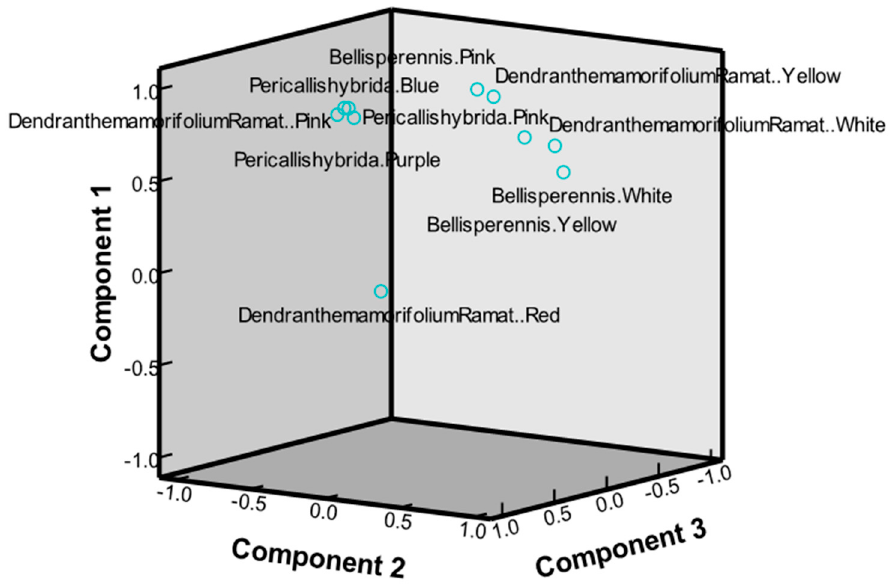
Figure 4. Eigenvalues and their contribution through the PCA using hydrocarbons, terpenoids, aromatic compounds, alcohols, ketone, ether, aldehyde, and ester volatile compounds of 10 taxa of Chrysanthemum.